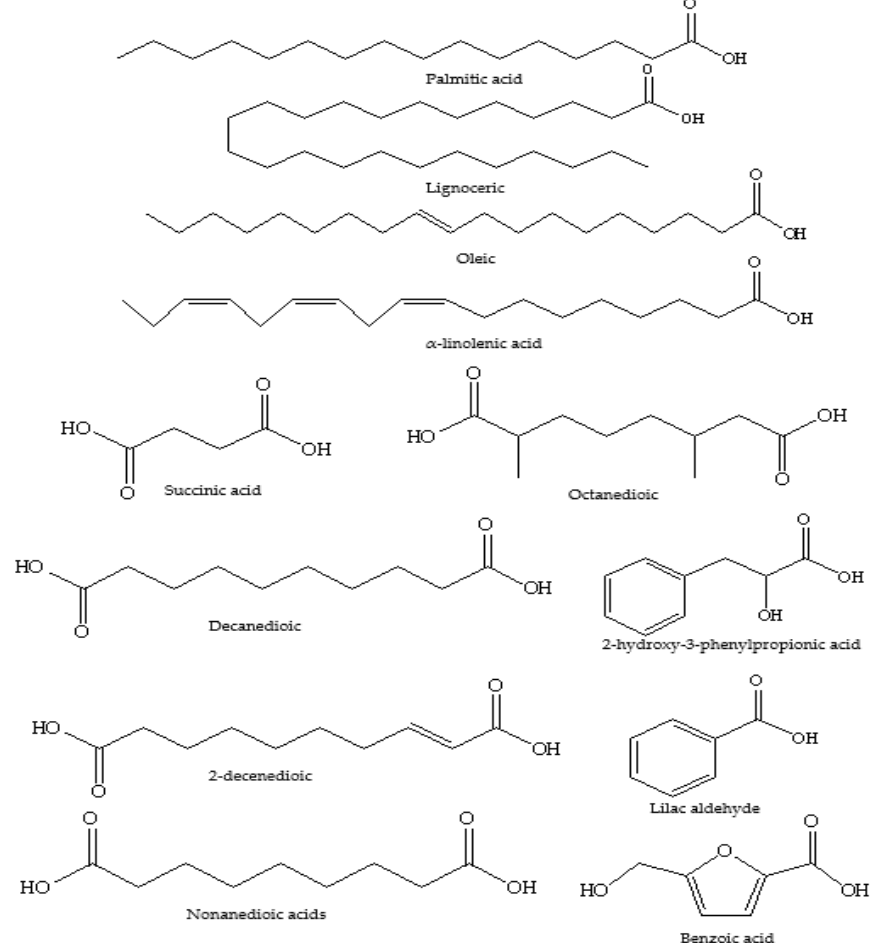
Figure 11. Structure of compounds reported in white clover honey.